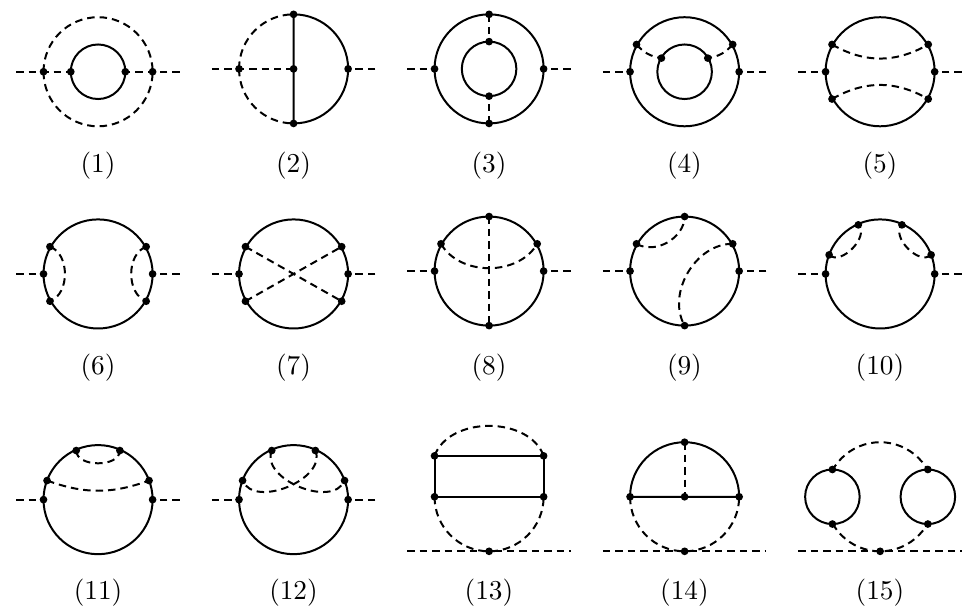
Figure 1 . Fermionic (solid lines) and scalar (dashed lines) diagrams potentially giving rise to three-loop corrections of scalar field anomalous dimensions. One additional diagram providing a purely scalar contribution is not